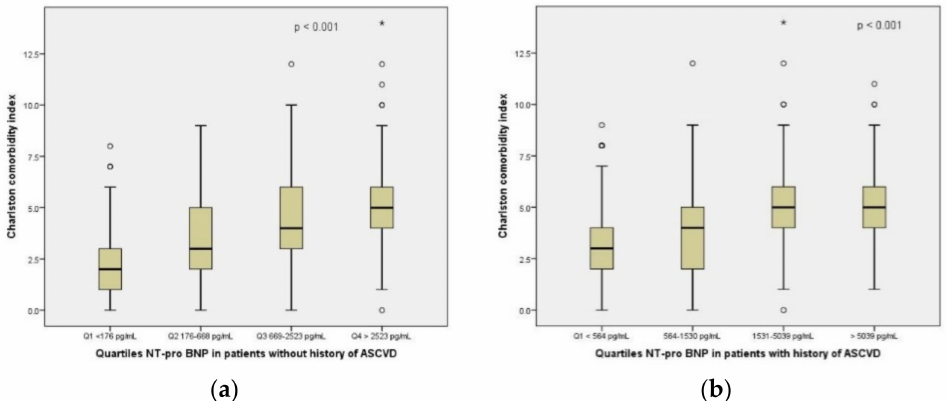
Figure 1. CCI is correlated with NT-pro BNP quartiles, based on the history of ASCVD: ( a ) CCI score and NT-pro BNP quartiles in patients without history of ASCVD; ( b ) CCI score and NT-pro BNP quartiles in patients with history of ASCVD. ◦ , represent outliers; *, represent extreme values. Table 3. Cox proportional hazards model assessing the relationship between N-terminal B-type natriuretic peptide and the main outcome adjusted for multiple relevant covariates, in relation with history of ASCVD. Patients without ASCVD Patients with ASCVD Univariate Multivariate Univariate